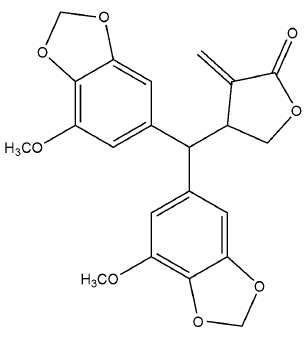
Figure 1. Chemical structure of peperomin E.